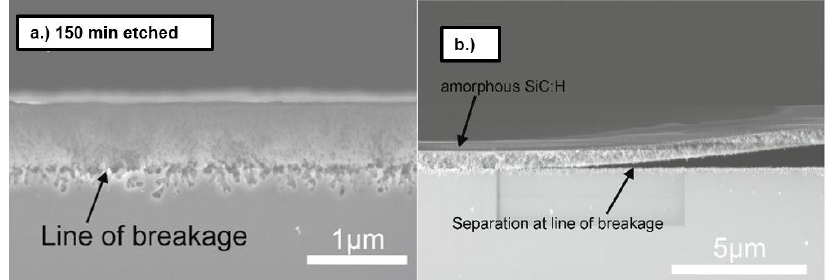
Figure 1. SEM micrographs of porous silicon carbide generated with MAPCE ( a ) After 150 min of etching. A highly porous layer with a line of breakage at the bottom [5] ( b ) Porous SiC covered with 0.5 µm of amorphous